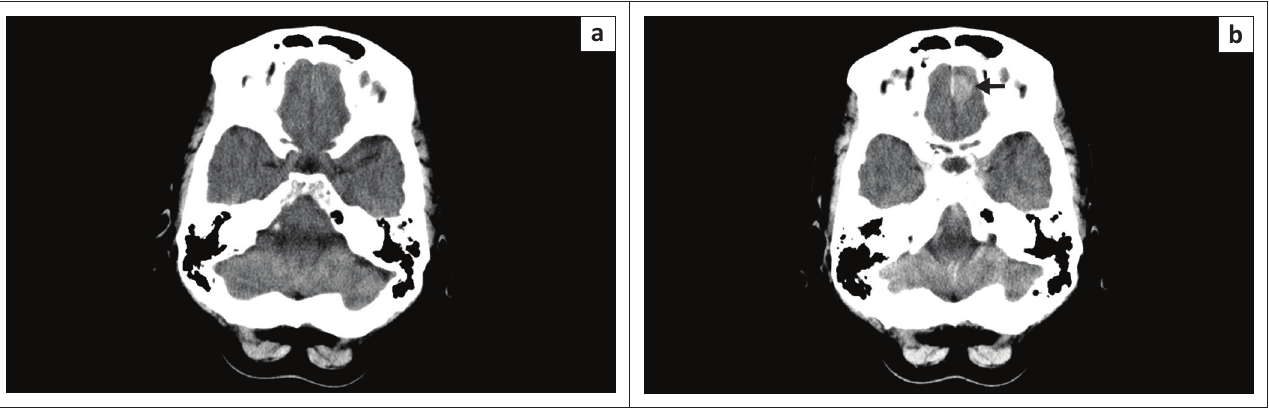
NECT, non-contrast-enhanced computed tomography; CECT, contrast-enhanced computed tomography. FIGURE 5: (a) NECT and (b) CECT of the brain. The NECT is apparently normal but the CECT demonstrates a small well-defined enhancing lesion (arrow). Meningioma was reported the most likely